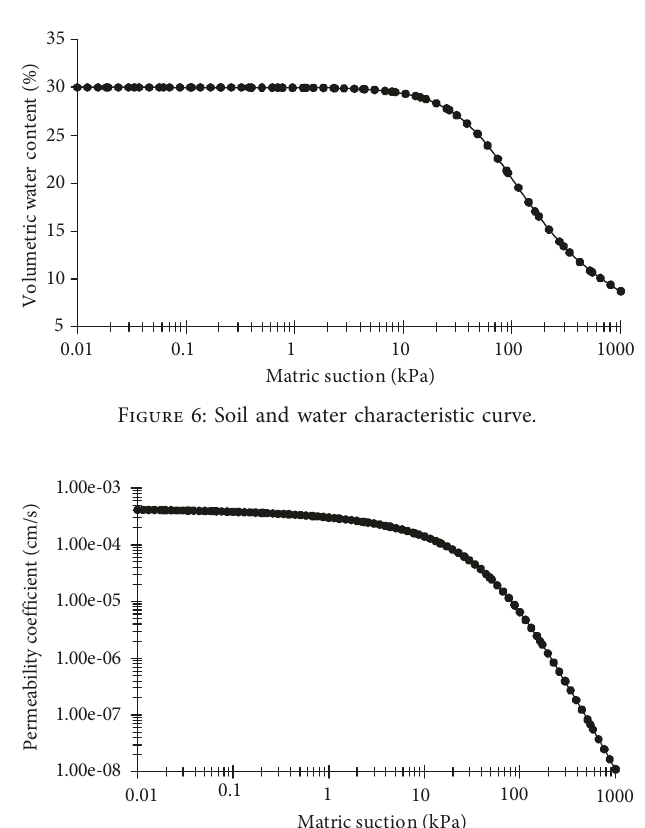
Figure 7: Permeability coefficient curve.